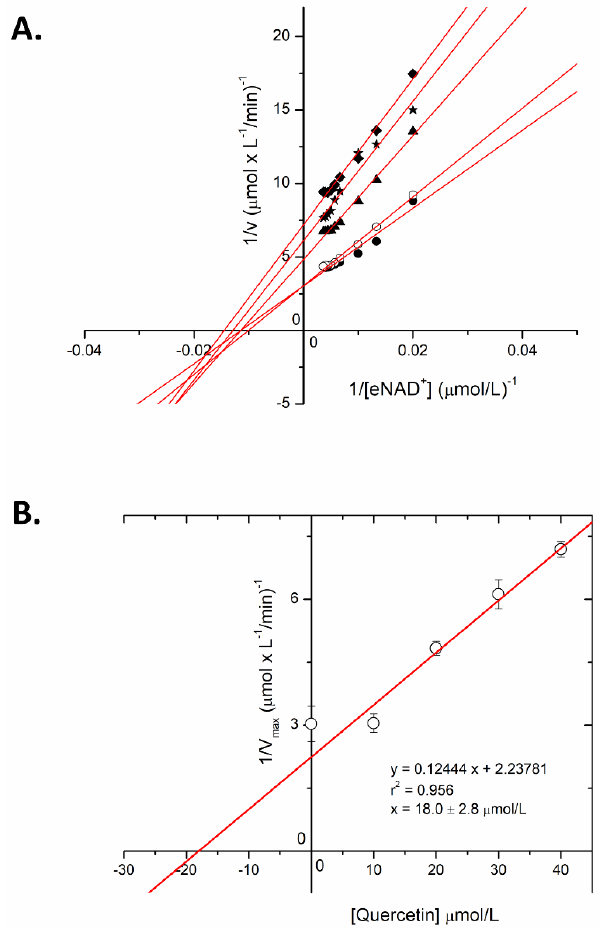
Figure 5. Inhibition of Plx2A GH activity with Quercetin. ( A ) Lineweaver–Burk plots of Quercetin GH activity inhibited by Quercetin. The assays were described in the Materials and Methods in the presence of 5 µ mol/L Plx2A and a gradient of ε -NAD + concentrations (0 µ mol/L–400 µ mol/L) in GH buffer (50 mmol/L NaCl, 20 mmol/L Tris), pH 7.5, at 25 ◦ C with 15% DMSO in the solution to provide solubility to the flavonoid. ( B ) Secondary plot based on the non-competitive inhibition pattern for Quercetin against Plx2A GH activity. The intercept on the abscissa revealed the K i value (18.0 ± 2.8 µ mol/L). The experiments were conducted in triplicate with means calculated ±